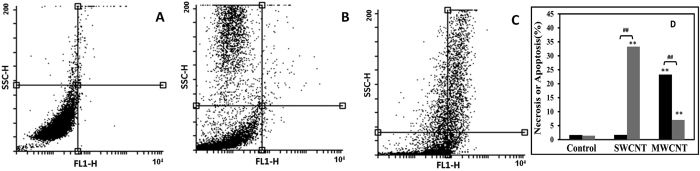
Flow cytometry assay to evaluate cell death.Cells were co-labeled with PI and Annexin V-FITC, and analyzed by flow cytometer. The histograms of untreated control cells (A), cells exposed to MWCNT for 48 h (B) and cells exposed to SWCNT for 48 h (C). The percentage of apoptotic (black) and necrotic (gray) cells after 48 h incubation with SWCNT and MWCNT (D). Lower left quadrant shows the control surviving cells. The early apoptosis is presented in the lower right quadrant, and the late apoptosis is presented in the upper right quadrant. The necrotic cells are presented in the upper left quadrant. *P < 0.05 and **P < 0.01 represents the significant differences between CNTs –treated groups and control. #P < 0.05 and ##P < 0.01 represents the significant differences between MWCNT –treated groups and SWCNT –treated groups.